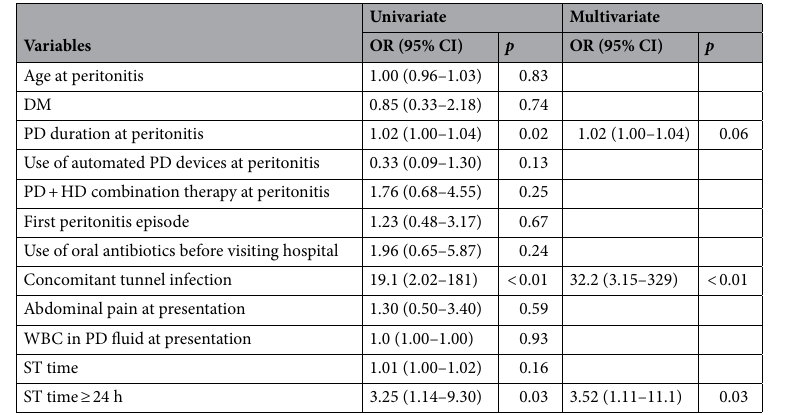
Table 2. Results of univariate and multivariate logistic regression analysis for catheter removal.